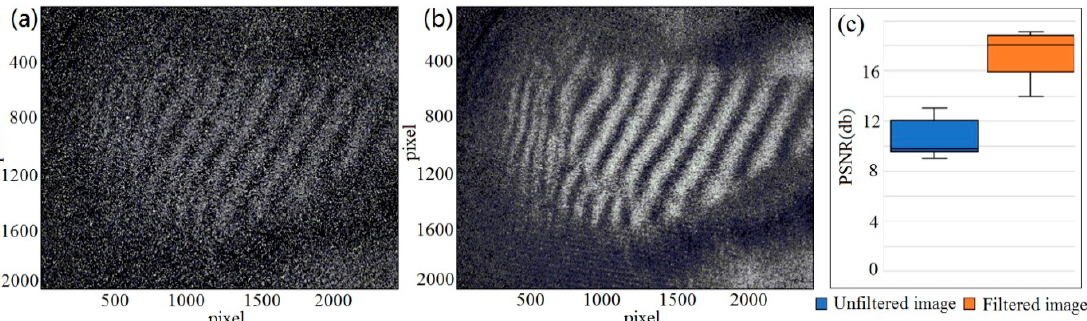
Figure 6. The comparison images of time-domain mean filter, ( a ) original image of interference fringe pattern, ( b ) filtered image by TDMF, ( c ) PSNR of original image of ( a ) and the filtered image of ( b ).